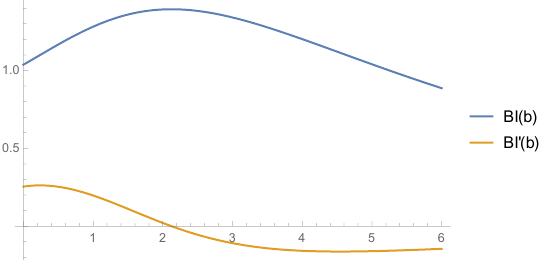
Figure 3. Optimizing dividends with affine drawdown stopping where µ = 1/2, q = 1/10, σ = 1, ξ = 1/3, b = 20, d = 1. The critical point b ∗ =